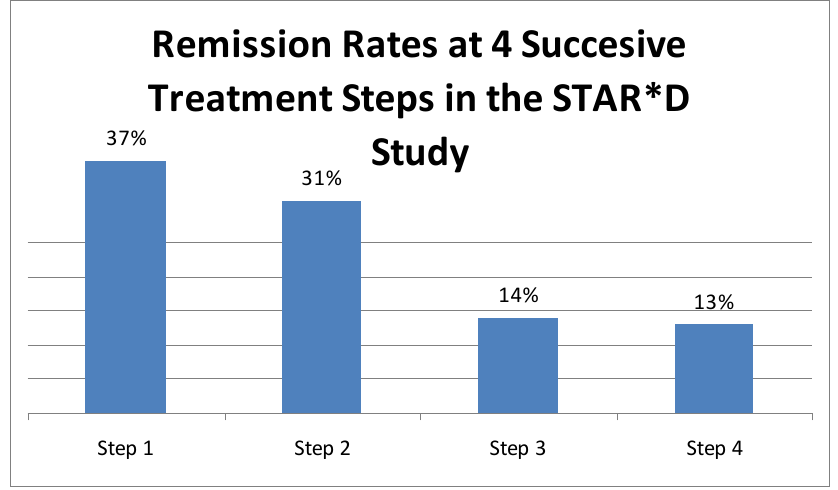
Figure 3. Sequential remission rates at each step in the STAR*D